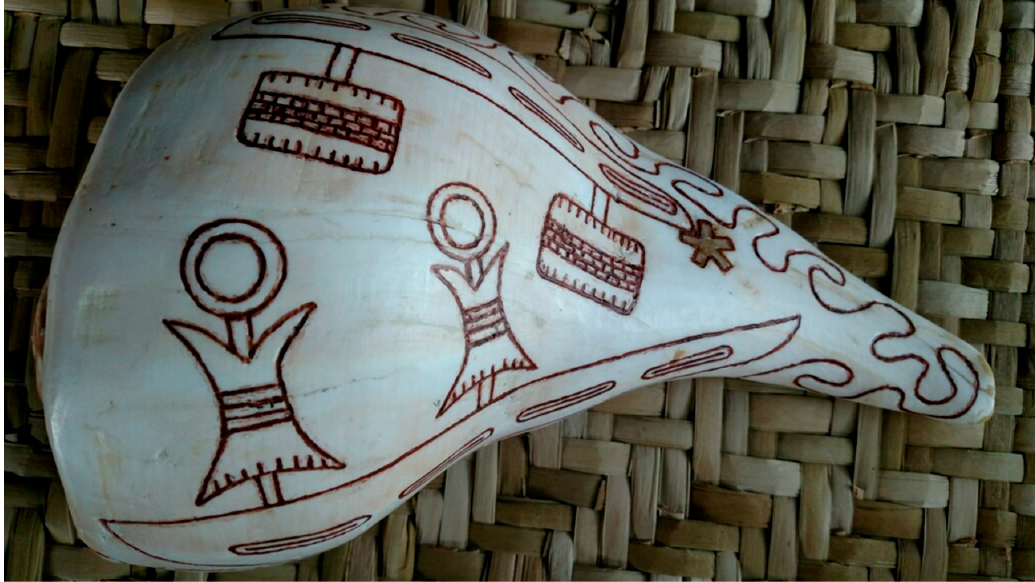
Figure 1. A shell engraved by a community member, Simon. The design is based on a shell cup excavated from Spiro Mounds, a site in Oklahoma dated to c. 940–1540 CE, which depicts four persons (omitted in Simon’s rendition) in canoes. Simon and others in his community interpret this design as representing a constellation of the four Original Teachers that circles the North Star. The rectangular motifs atop the upper canoe are interpreted as seed boxes, while the four-pointed motifs on the other canoe are interpreted as stylized turtles. The circles are described as top-down views of the cosmos. Photograph courtesy of Simon. Religions 2019 , 10 , x FOR PEER REVIEW